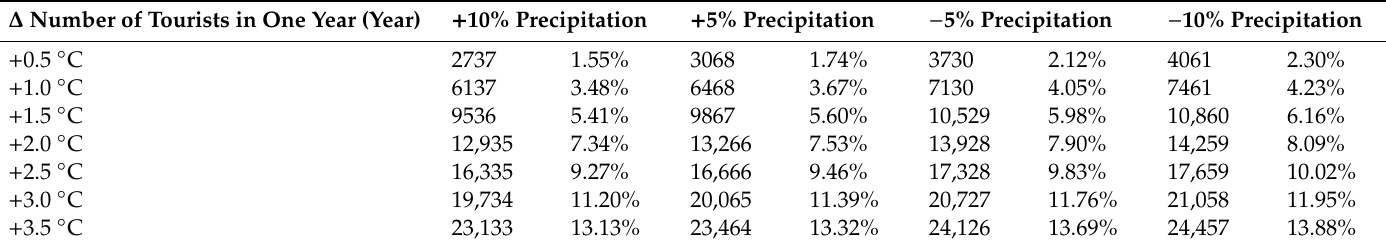
Table 9. Number of tourists increase in one year (persons per season) and increate rate (%). ∆ Number of Tourists in One Year